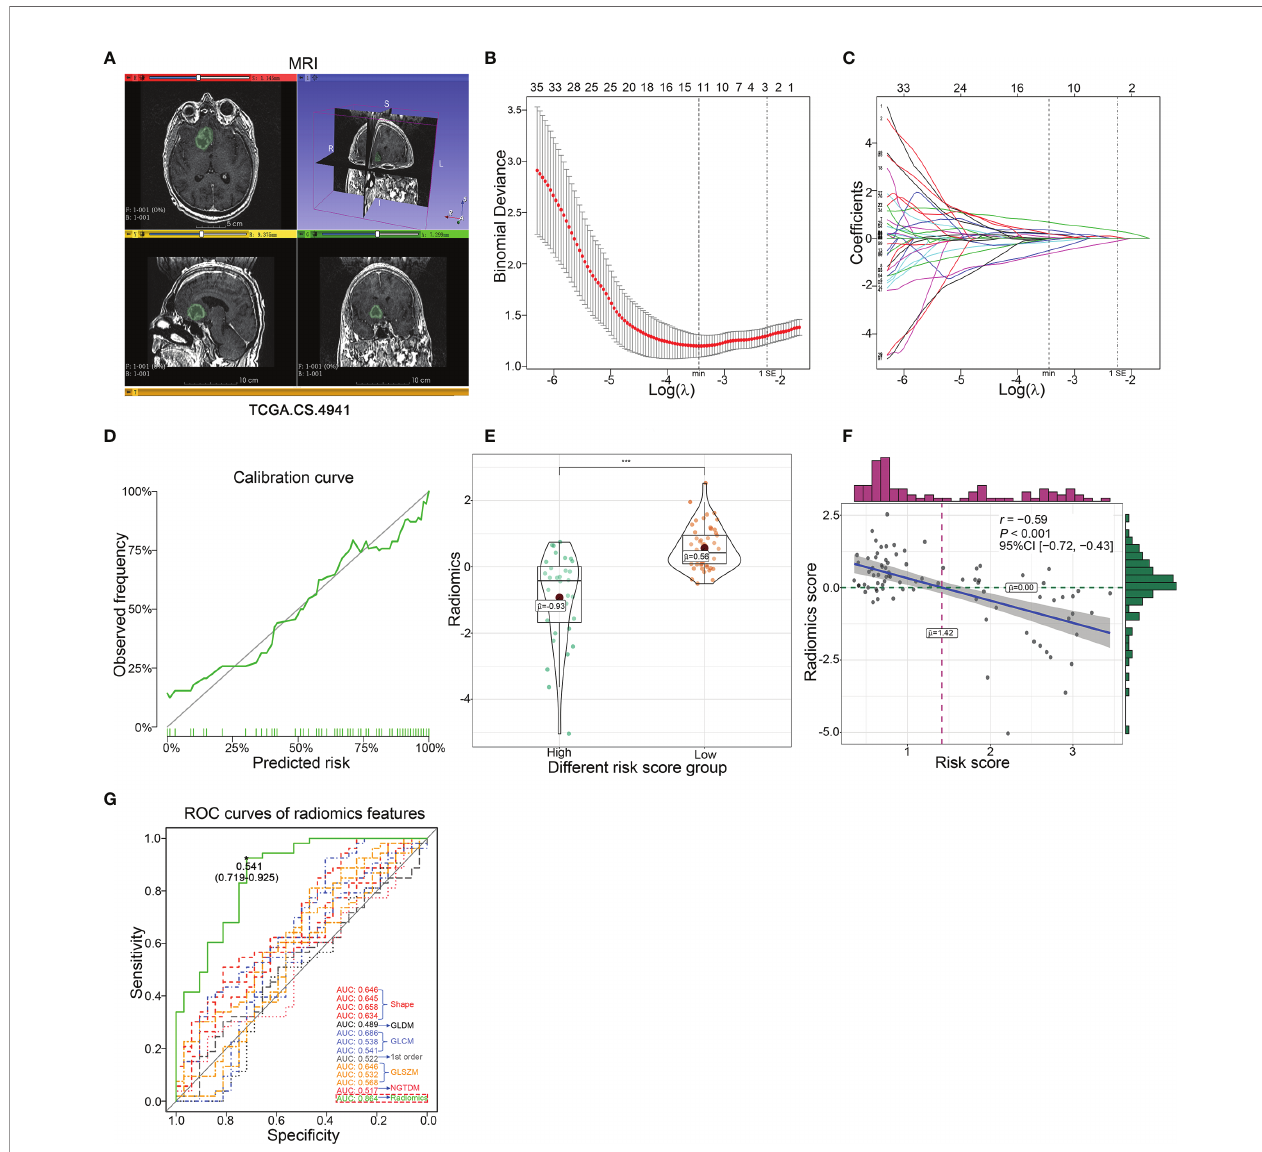
FIGURE 5 | Development and validation of the predictive radiomics risk score in TCGA dataset. (A) The representative MRI image derived from TCGA.CS.4941 reconstructed by 3D Slicer based on TCIA. (B) The radiomics features were selected by LASSO logistic regression with10-fold cross-validation for tuning parameter ( l ) selection in TCGA cohort, in which the vertical dashed lines showed minimum l value and 1× standard error l value, respectively. (C) The LASSO coef fi cient pro fi le of all candidate radiomics features in TCGA cohort, in which the vertical dashed lines showed minimum l value and 1× standard error l value, respectively. (D) The calibration curve of radiomics risk score. (E) The difference of radiomics risk score in different transcriptional risk score groups with an optimal cutoff of 1.7 calculated by X-tile (*** p < 0.001, with t test). (F) The correlation presented signi fi cant negative correlation between radiomics risk score and transcriptional risk score in TCGA cohort ( p < 0.001, with Pearson correlation). (G) The ROC curve analysis of the transcriptional risk score group using 13 radiomics features and radiomics risk score,